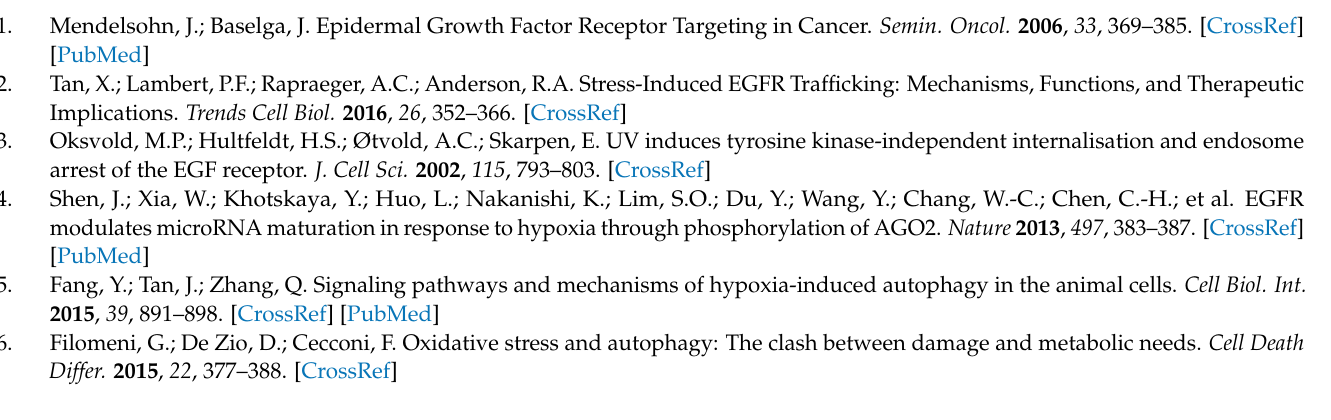
Figure S3: Uncropped western blot